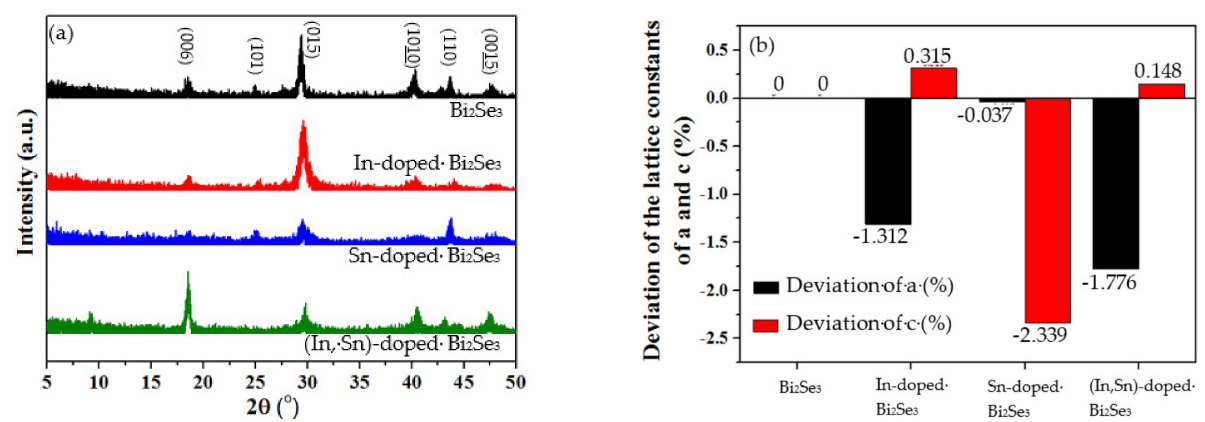
Figure 1. ( a ) XRD patterns and ( b ) deviations of the lattice constants a and c of pristine, and In-, Sn-, and (In, Sn)-doped Bi 2 Se 3 nanoplatelets. Table 1. Lattice constants a and c, c/a ratios of pristine, and In-, Sn-, and (In, Sn)-doped Bi 2 Se 3 nanoplatelets.